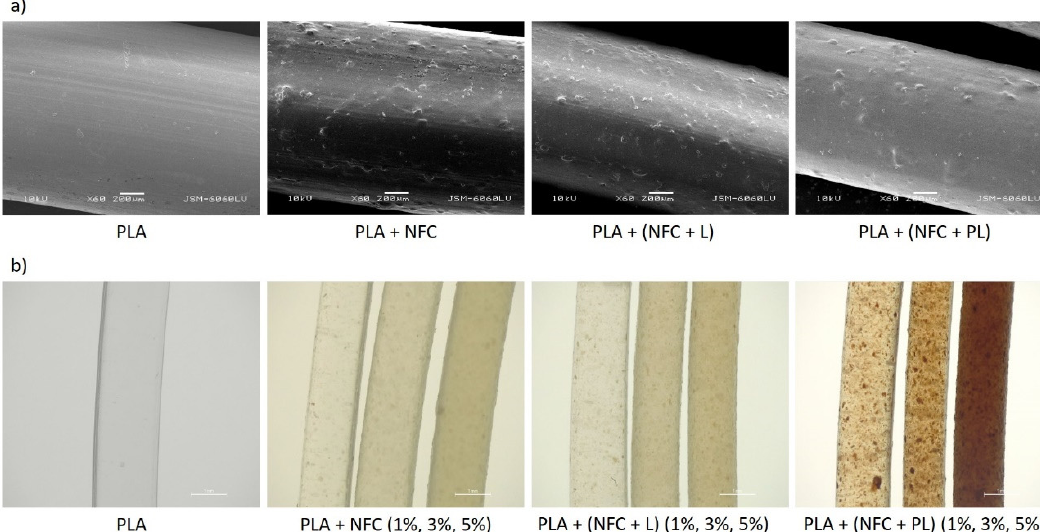
Figure 2. Surfaces of PLA, PLA + NFC, PLA + (NFC + L), and PLA + (NFC + PL) filaments captured by ( a ) SEM (magnification: 60 × ) and ( b ) stereomicroscope (magnification: 20 × ).